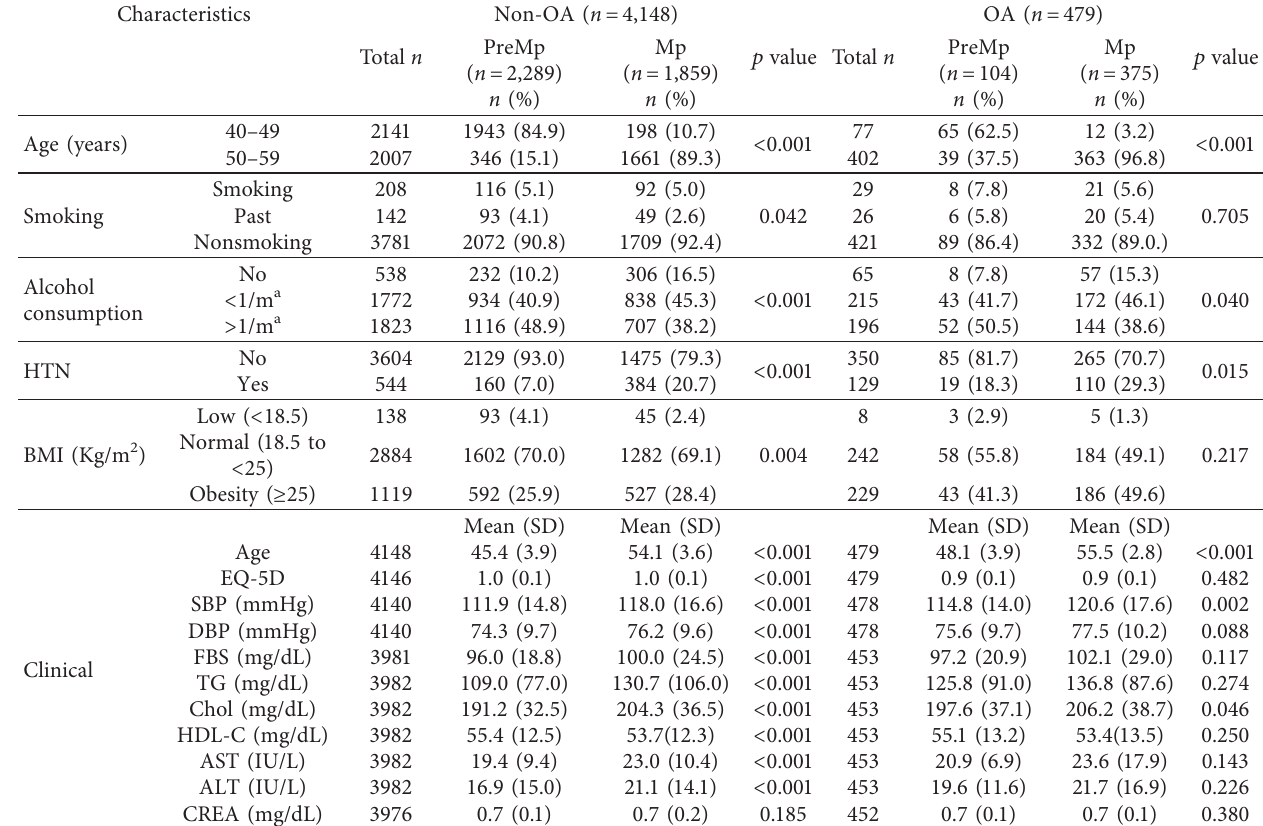
Table 2: Characteristics of the premenopausal and menopausal groups according to the osteoarthritis status.